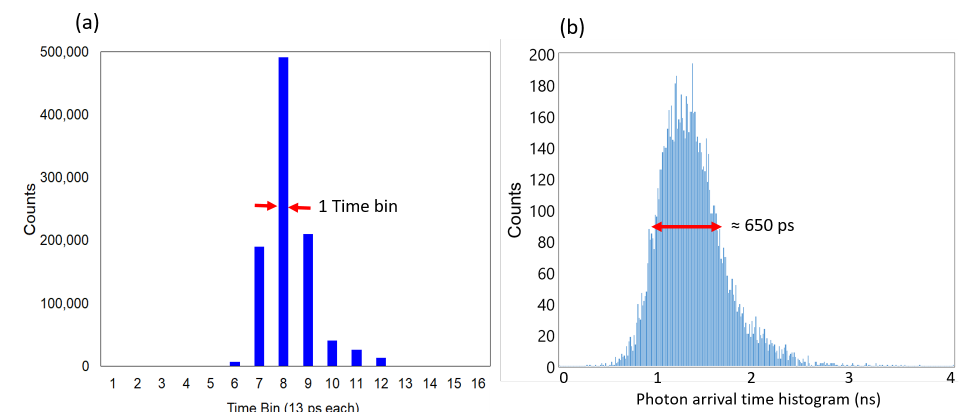
Figure 3. ( a ) Timing jitter histogram of the system reference clock derived using the pulse laser verifying the time resolution to be <13 ps. ( b ) Histogram of arrival time with an attenuated laser pulse by the means of time-correlated single-photon-counting measurement integrated over 10 s, indicating an FWHM pulse width of ≈ 650 ps.